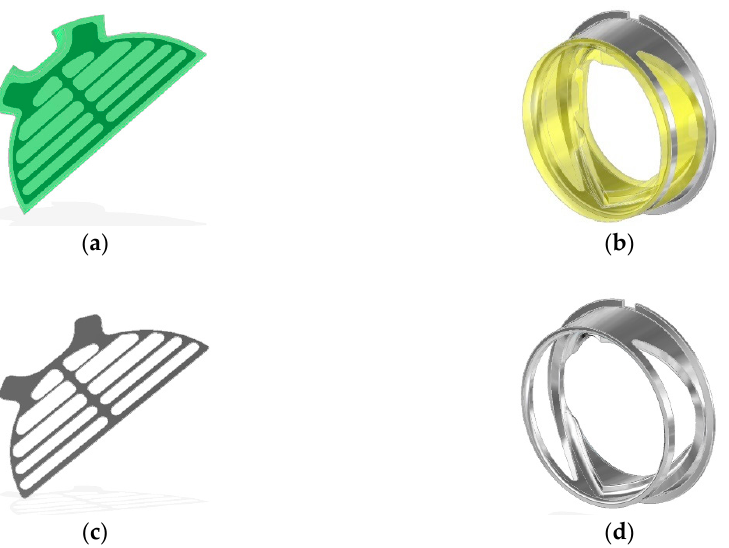
Figure 3. Outflow valve ( a ) and cross section ( b ) through the flow channel area.